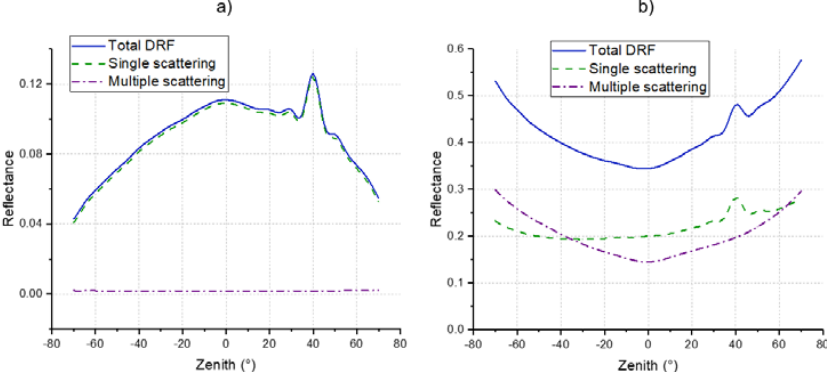
Figure 19. Contribution of single and multiple scattering to the DRF. ( a ) 670 nm, ( b ) 850 nm (third stage of growth).